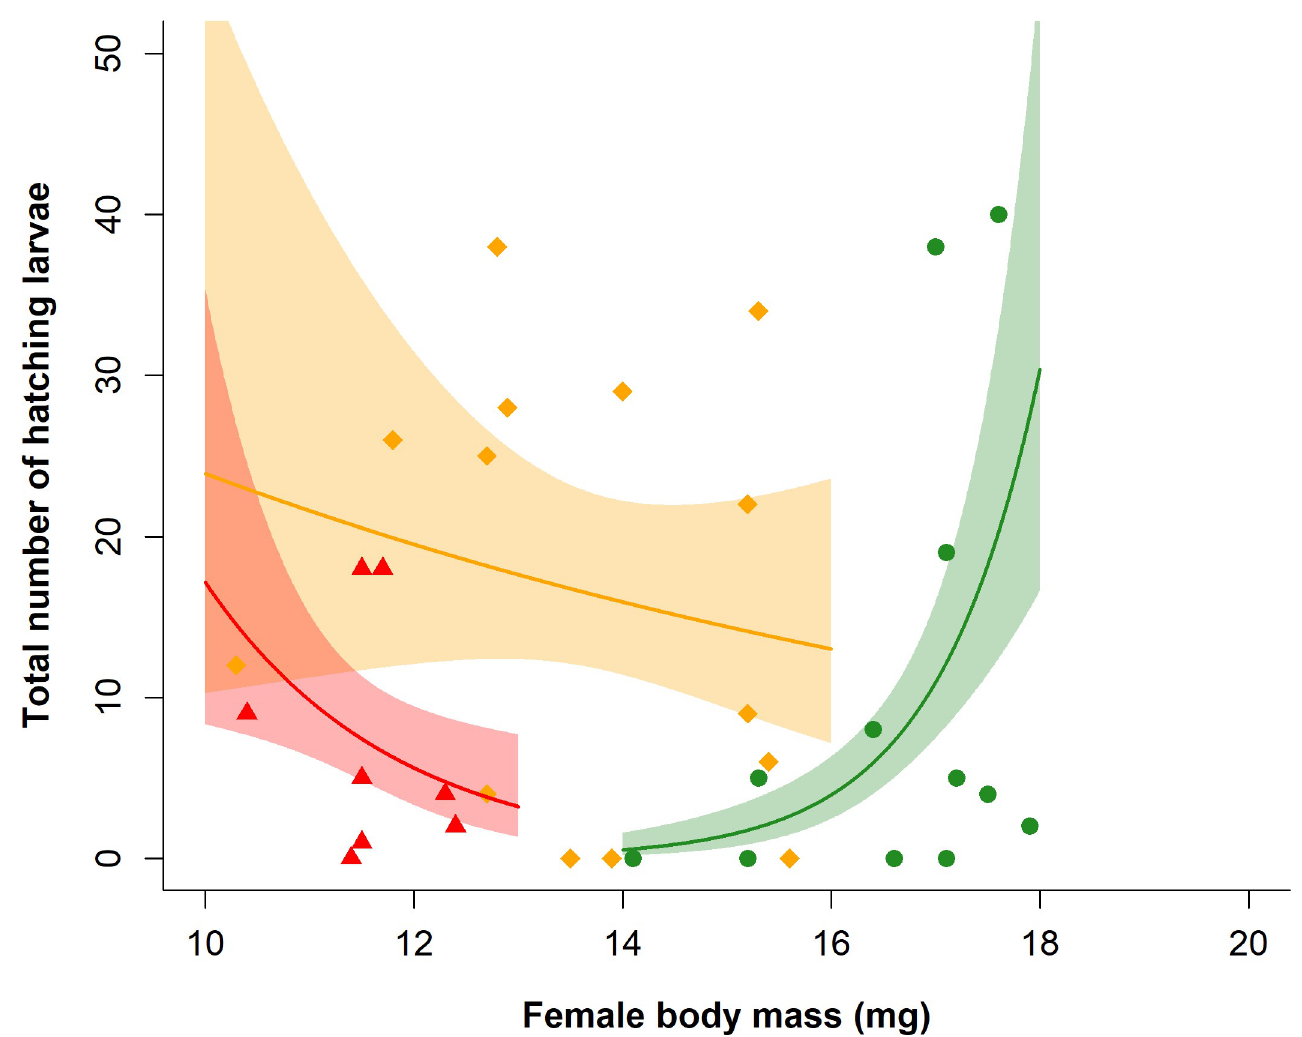
Fig 3. Effect of larval food treatment [green circles–no starvation (NS), orange diamonds–low starvation (LS), red triangles–moderate starvation (MS)] on the relationship between total number of larvae hatching from eggs laid by Athalia rosae F0 females and female body mass (mg). Lines represent model predictions with associated SE plotted as polygons around each line and overlaid with raw data